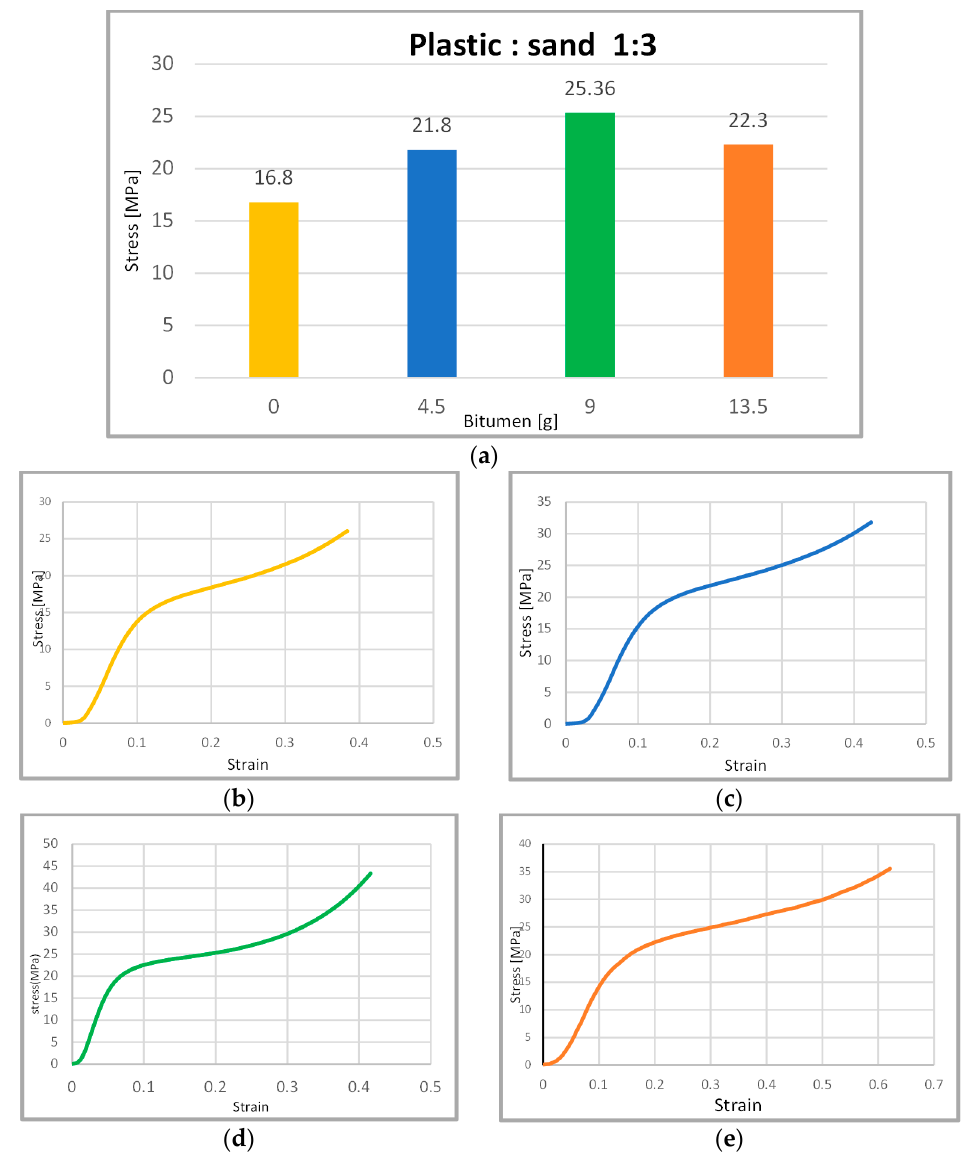
Figure 6. Results of brick sample 5. ( a ) Compression strength values of brick plastic-to-sand 1:3. ( b ) Stress–strain curve with 0 g bitumen. ( c ) Stress–strain curve with 4.5 g bitumen. ( d ) Stress–strain curve with 9 g bitumen. ( e ) Stress–strain curve with 13.5 g bitumen.